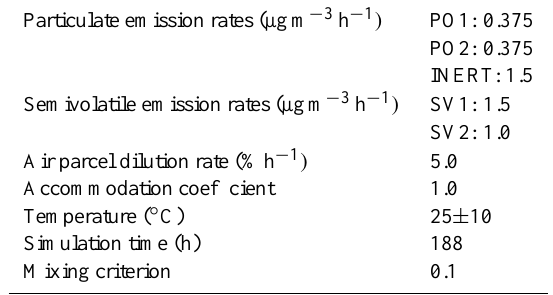
Table 1. Model parameters for base case